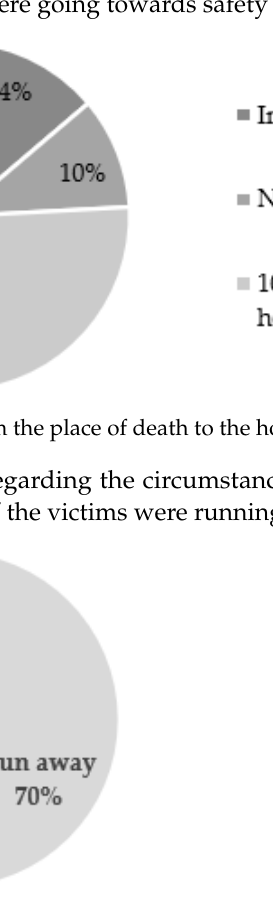
Figure 5. Circumstance of the death direction-June 2017 [16].